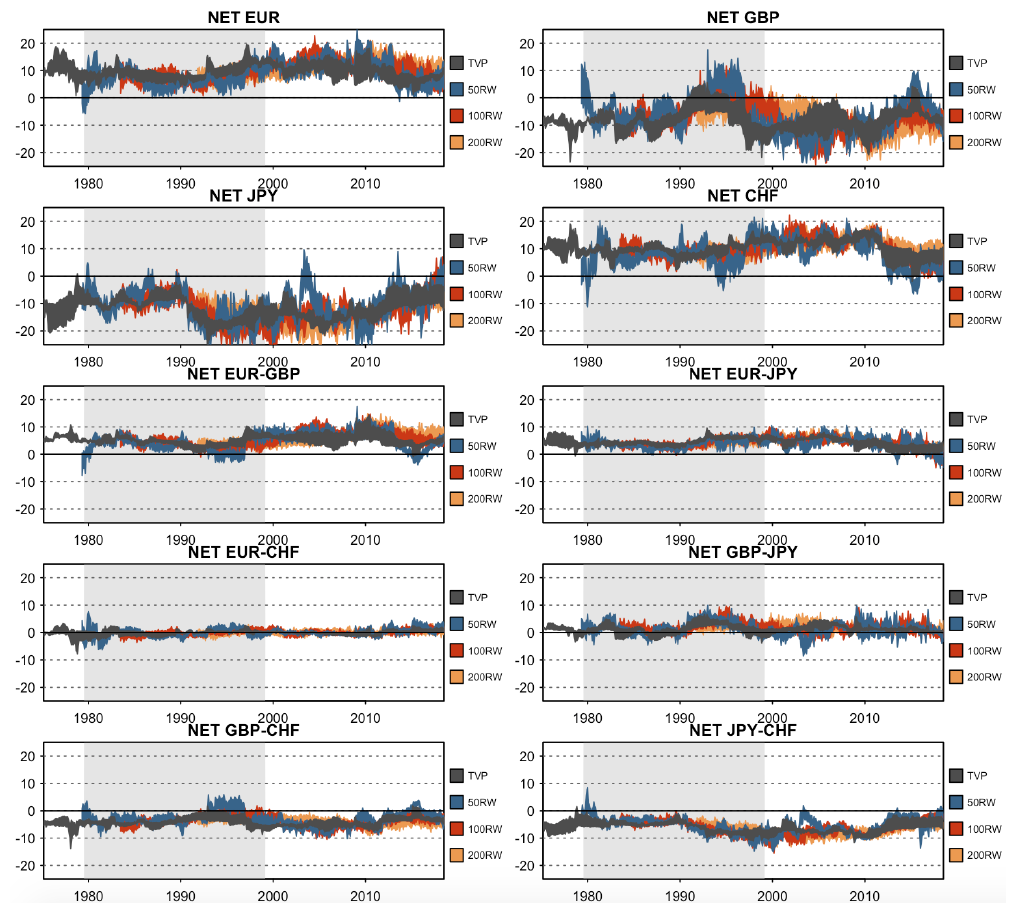
Figure 14. Confidence intervals: Net total and net pairwise directional connectedness measures of uncertainty.